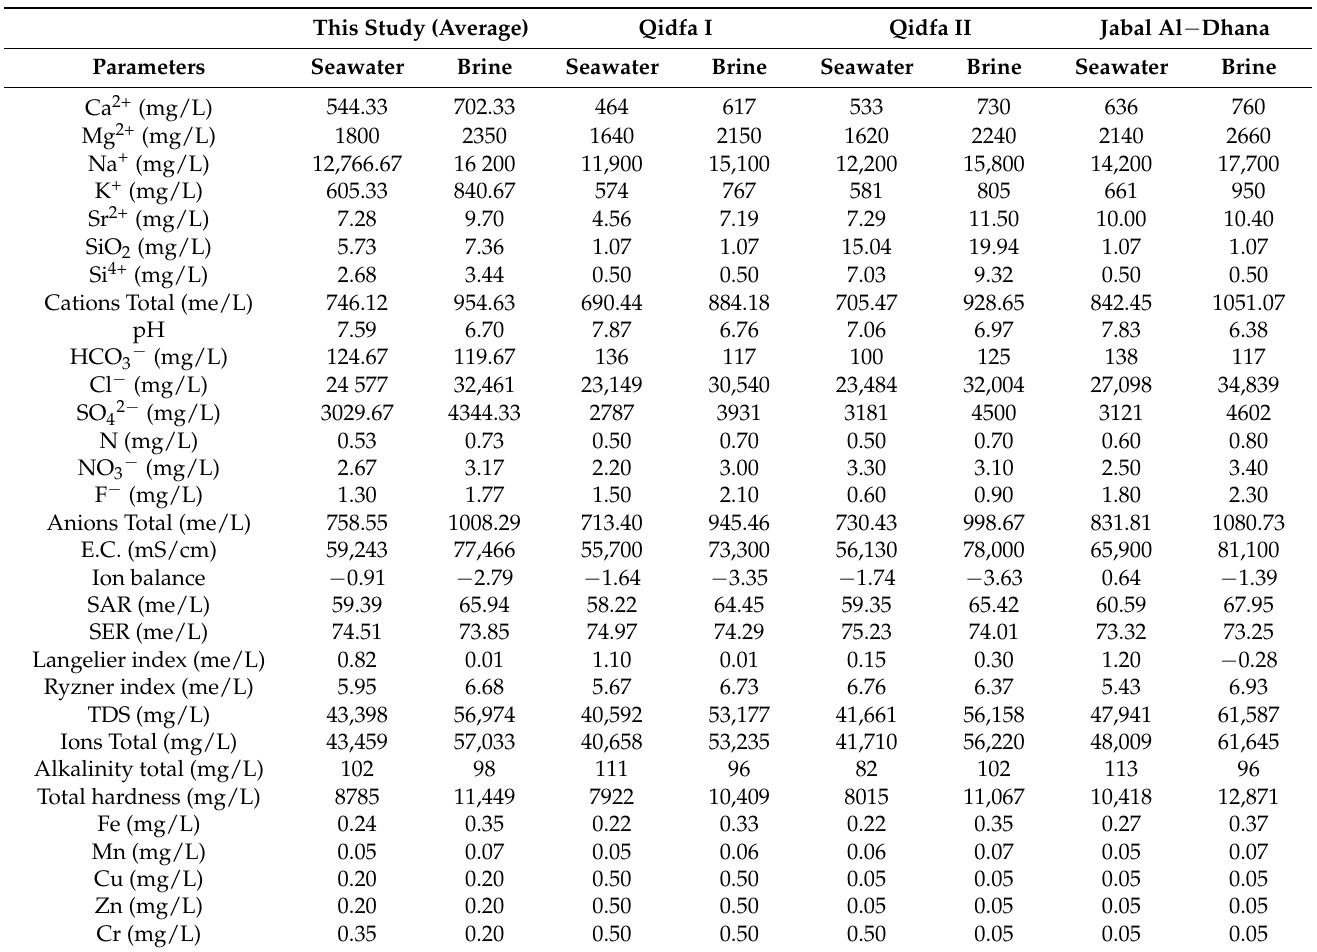
Table 3. Composition of the brine used in this study along with the composition of seawater and brines from three different desalination plants in